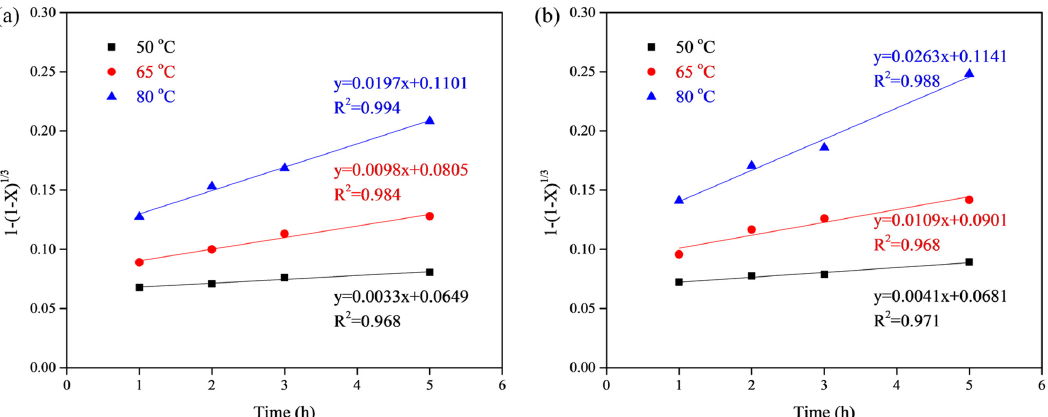
Figure 13. Kinetic constants obtained from fitting the chemical reaction model (Equation (9)) over time for three temperatures during ( a ) non-UAL and ( b ) UAL.